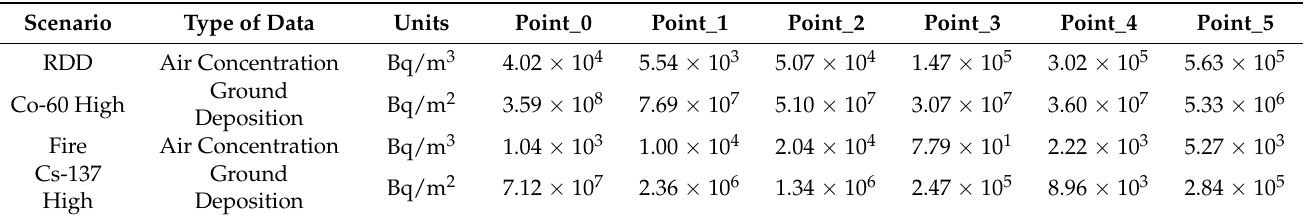
Table 6. Comparison of the two simulations (detonation vs. fire), reporting the shape and concen- tration values of the radioactive clouds.